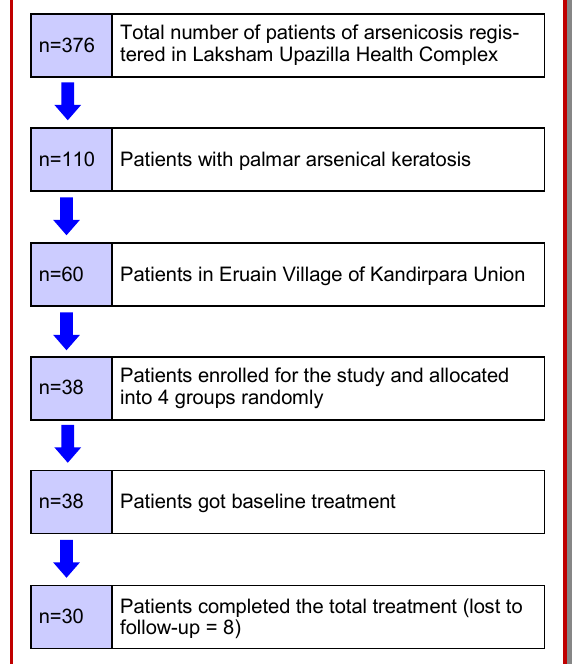
Figure 1: Steps of enrolling